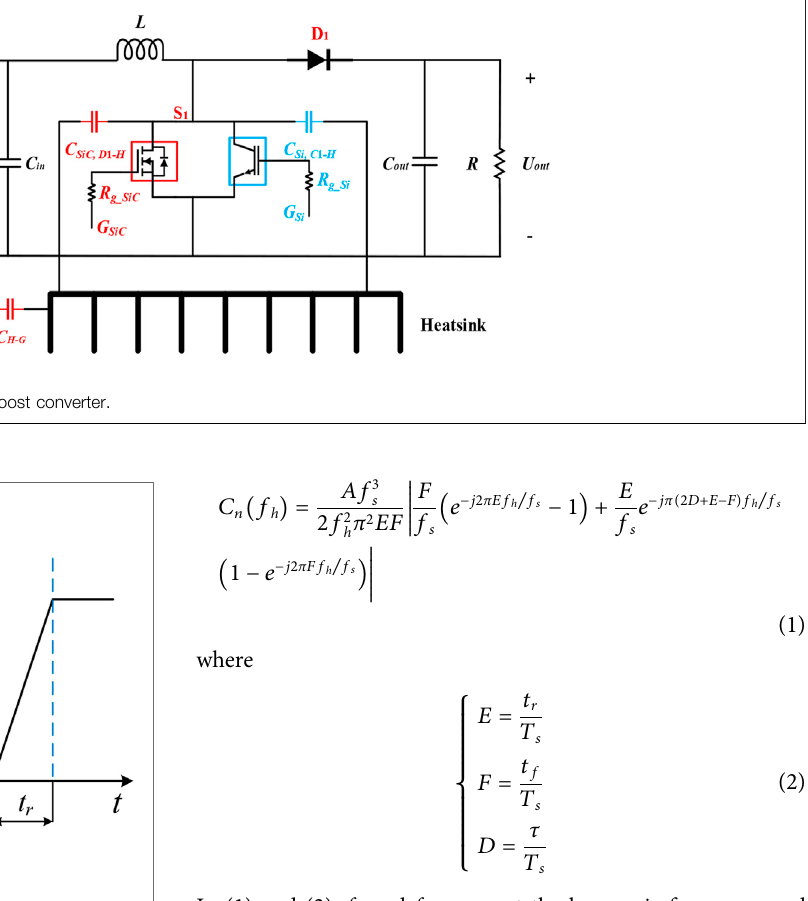
FIGURE 2 | Asymmetrical trapezoid representing the CM voltage of the Si/SiC hybrid switch (Han et al., 2017b).